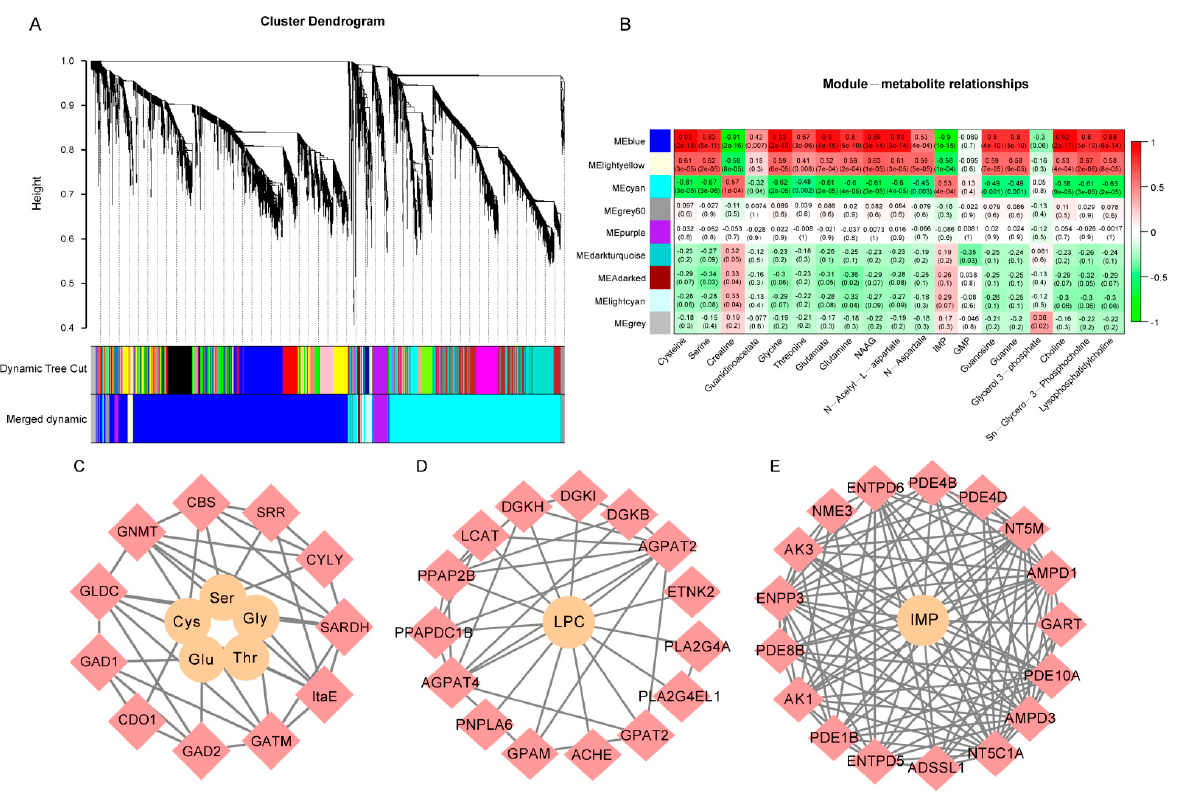
Figure 4. Joint analysis of significantly changed metabolites (SCMs) and differentially expressed genes (DEGs) of breast muscle at four developmental stages of Beijing-You chicken (BJY). ( A ) Nine clustering modules with different expression trends of DEGs obtained by overweighted gene co-expression network analysis (WGCNA). The dendrogram shows DEG co-expression clusters. Different colors indicate DEG co-expression modules. ( B ) Heatmap showing module–metabolite relationships. Each row represents a different modules obtained from the WGCNA analysis. Each column represents a metabolite. Red indicates that there was a positive correlation between this cluster and the metabolite, and green indicates a negative correlation. The numbers in the module indicate the corresponding p-value and correlation coefficient. ( C ) Interaction network of amino acids and DEGs by cytoscape. Yellow circles represent amino acids. Pink diamonds represent DEGs involved in amino acids metabolism. ( D ) Interaction network of lysophosphatidylcholine (LPC) and DEGs. Yellow circles represent LPC. Pink diamonds represent DEGs involved in LPC biosynthesis. ( E ) Interaction network of inosine monophosphate (IMP) and DEGs. Yellow circles represent IMP. Pink diamonds represent DEGs involved in IMP biosynthesis.